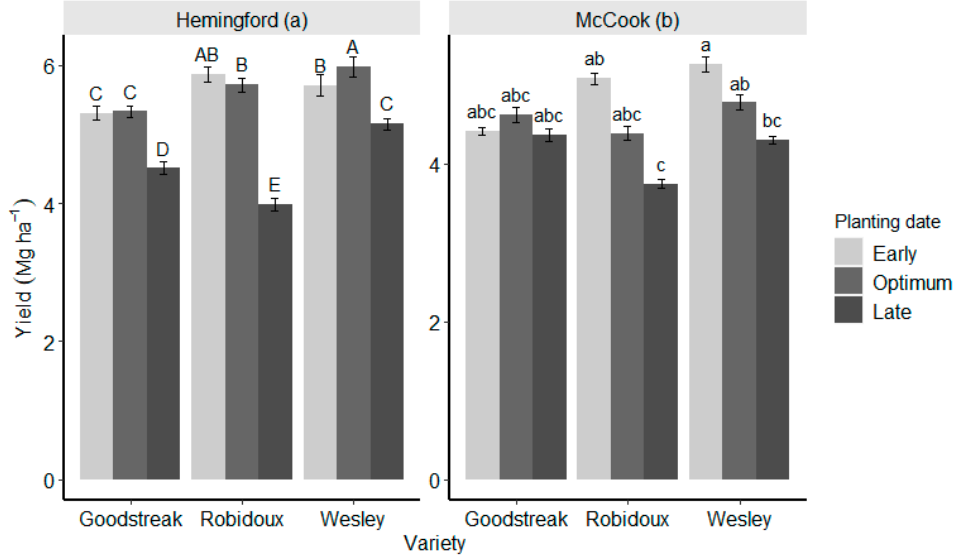
Figure 2. Winter wheat grain yield as affected by the interaction between planting date and variety at Hemingford and McCook experimental sites. The error bars represent the standard error of the mean. Different letters on top of column bars of each panel indicate a significant mean difference at p <